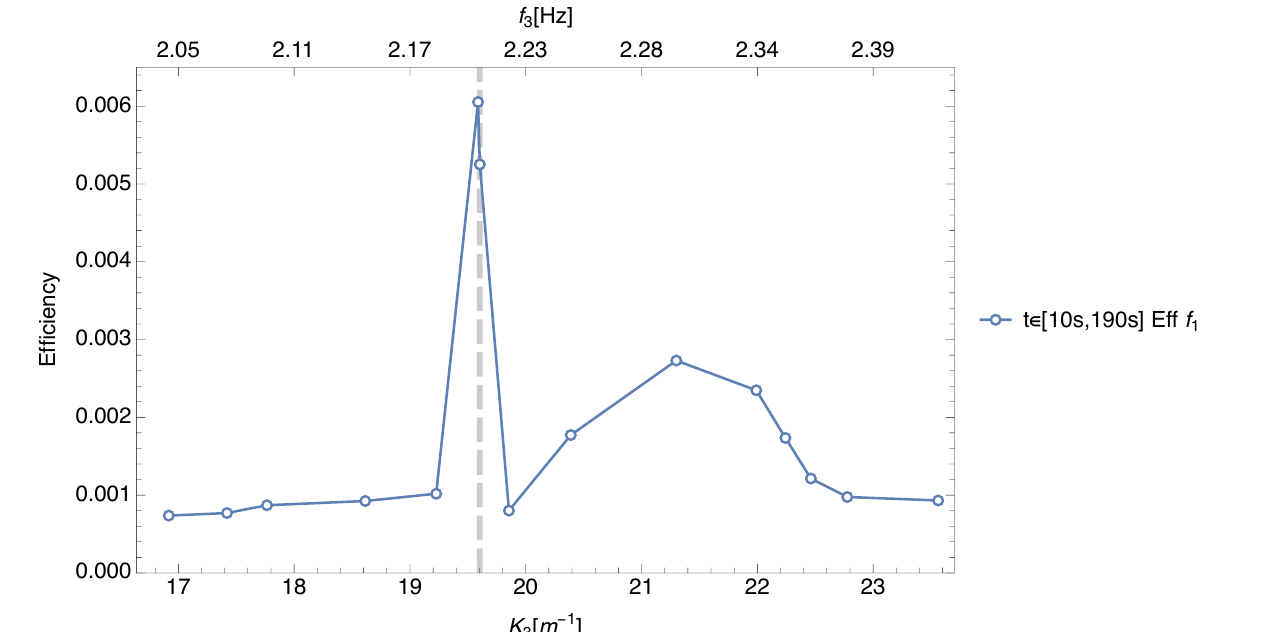
Figure 6. Efficiency as a function of the experiment, parameterised by the corresponding wavevector K 3 , for the plane-wave case for a long time series [0, 200 s]. The efficiency is defined as the sum of the squares of the scaleogram signals in Figure 5, on a strip of width 0.05 f 1 about f 1 and between the vertical lines in the figure, divided by the sum of squares over the whole range of frequencies, including f 2 which is not shown. An efficiency of 0.006 corresponds to 0.6% efficiency. The dashed grey vertical line corresponds to the theoretical resonant case K 1 : K 2 : K 3 = 16 : 9 : 25.